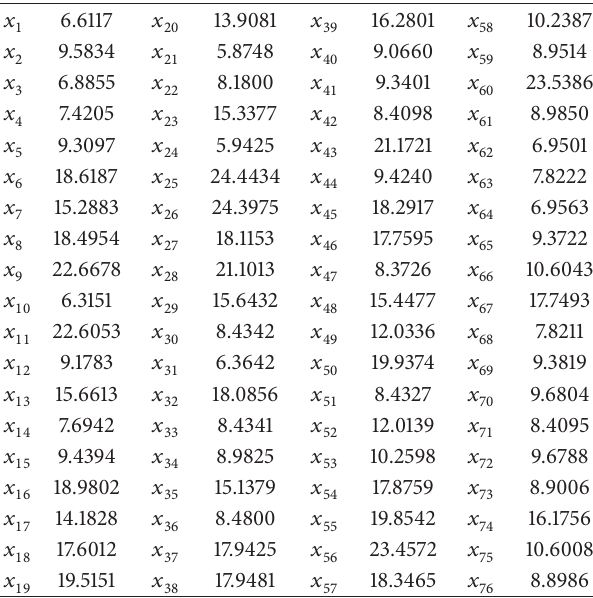
Table 11: The resulting equilibrium link flows from solving Sioux Falls